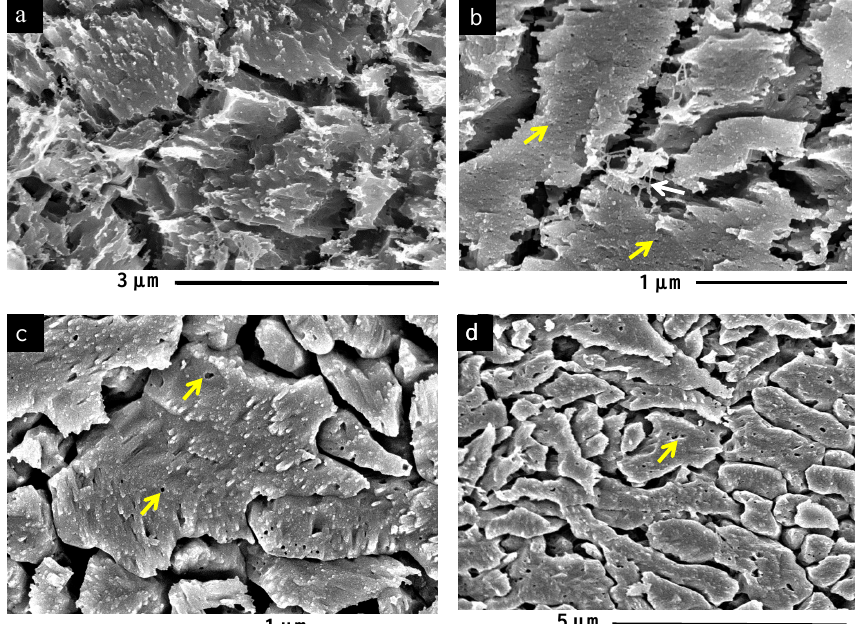
Figure 5. FE-SEM micrographs that zoom into experimentally altered Arctica islandica shell material shown in Fig. 4. 10mM NaCl + 10mM MgCl 2 aqueous solution (burial fluid) was used for alteration at 100 ◦ C for 28 days (a, b) and at 175 ◦ C for 7 days (c, d) . Panels (a) and (c) show portions from the seawater-adjacent shell layers; (b) and (d) depict material from shell layers at the soft tissue of the animal. The biopolymers have decomposed and dissolved in the material treated at 175 ◦ C (c, d) . Readily observable are minute round holes within the mineral units (yellow arrows in b, c, d ) that were filled in the pristine shell, prior to alteration, by biopolymer fibrils. For further details concerning the interlinkage between mineral units and nanoparticles with organic matrices, see Figs. A7 and